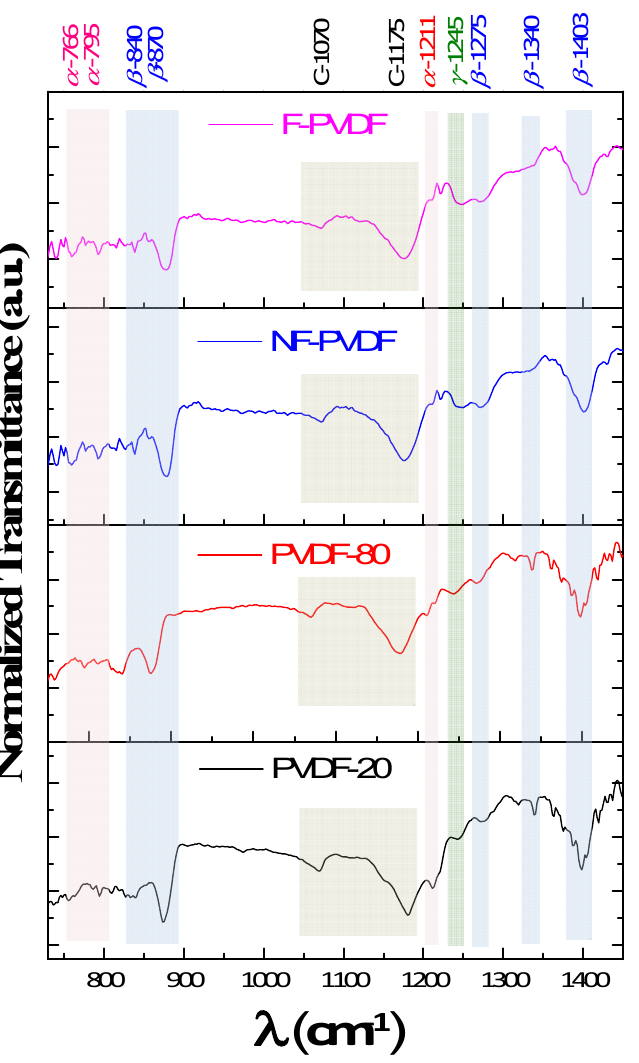
Figure 2. Infrared absorption bands typical of the β and α phases were identified, and they are presented separately for neat PVDF films (PVDF-20 and PVDF-80) and hybrid ones with non-functionalized nanoparticles (NF-PVDF) and functionalized nanoparticles (F-PVDF). Several bands located at 840, 870, 1275, 1340, and 1403 cm − 1 were clearly identified and characterized the β phase (see Figure 2) [13,14,48]. These bands were related to the sequences of more than three and/or four trans-conformations [13,14] of the polar phases. In Figure 2, the characteristic absorption peak at 840 cm − 1 was used to quantify the β -phase content, showing similar absorbance characteristics among the four samples. Non-polar α -phase absorptions were still visible, even though they were less intense, at 766, 795, and 1211 cm − 1 . The FTIR spectra also showed the presence of several absorption bands at 1070 and 1175 cm − 1 . These latter bands were characteristic of the vibrations of the carbon–carbon skeleton in the polymer [13,14,48]. Again, the intensities of these bands seemed not to evolve as a function of the thermal treatment and the presence of the nanoparticles, emphasizing a good organization of the polymer structure for all our samples. The quantification of the γ phase was more difficult, as exclusive FTIR bands corresponding to the γ phase appeared as shoulders (see Figure 2). Gregorio et al. [14,49] analyzed FTIR absorptions by assuming the Lambert–Beer law and calculated the absorption coefficients, K α and K β , at the respective wave numbers of 766 and 840 cm − 1 . In this manner,